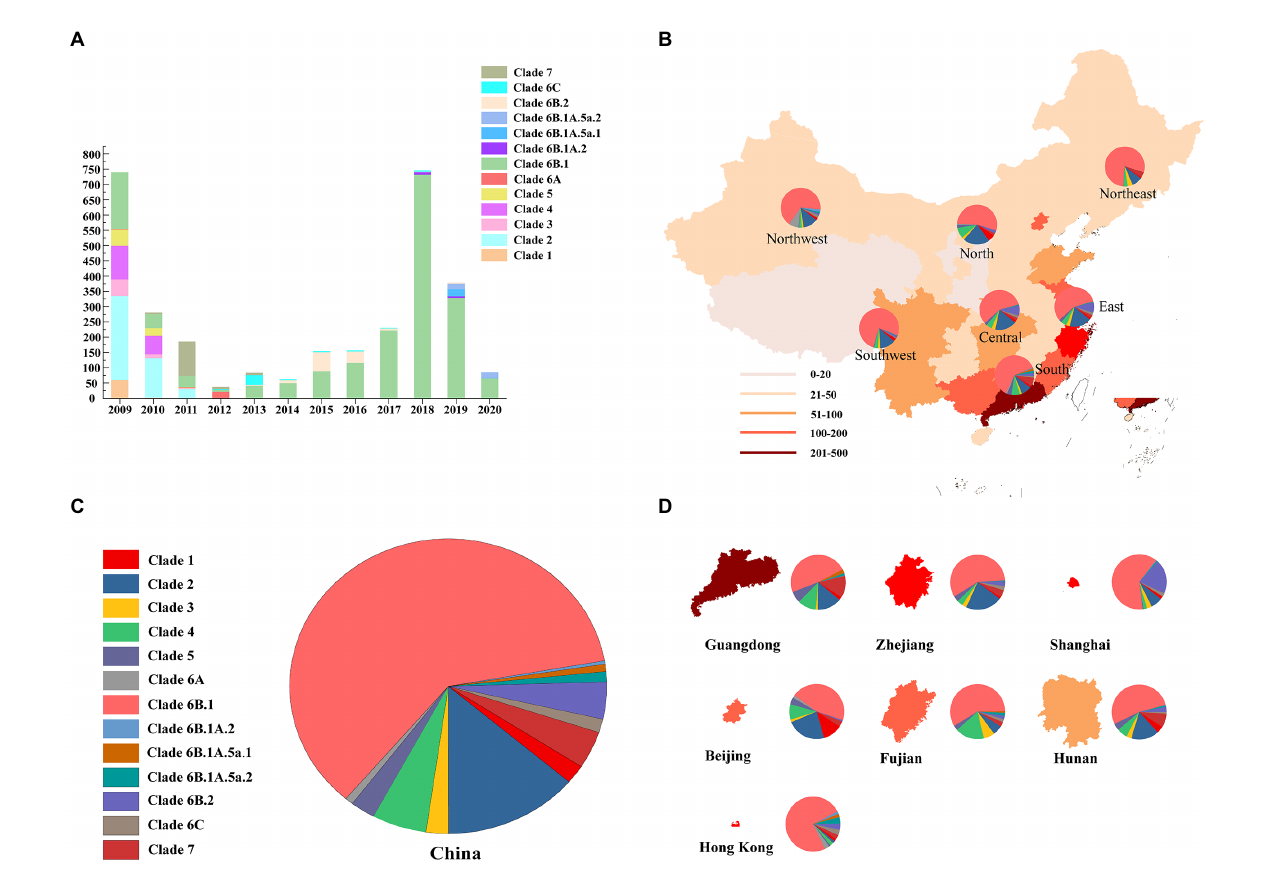
FIGURE 1 Geographic distribution and genetic diversity of pdm09 viruses in China. (A) Diversity of genotypes of pdm09 viruses isolated in China, 2009–2020. (B) A map of the pdm09 virus clades distribution; China was divided into seven different regions: North (Inner Mongolia, Hebei, Shanxi, Tianjin, and Beijing), North–East (Jilin, Liaoning, and Heilongjiang), North–west (Shaanxi, Gansu, Qinghai, Ningxia, and Xinjiang), East (Anhui, Jiangxi, Shandong, Fujian, Jiangsu, Shanghai, and Zhejiang), Central (Hubei, Hunan, and Henan), South (Guangdong, Hainan, Hong Kong, Macau, and Guangxi), and Southwest (Chongqing, Sichuan, Guizhou, Tibet, and Yunnan). (C) The proportion of HA gene of pdm09 viruses in China, 2009–2020. (D) The proportion of HA gene of pdm09 viruses in Guangdong, Zhejiang, Shanghai, Beijing, Fujian, and Hunan provinces as well as Hong Kong,